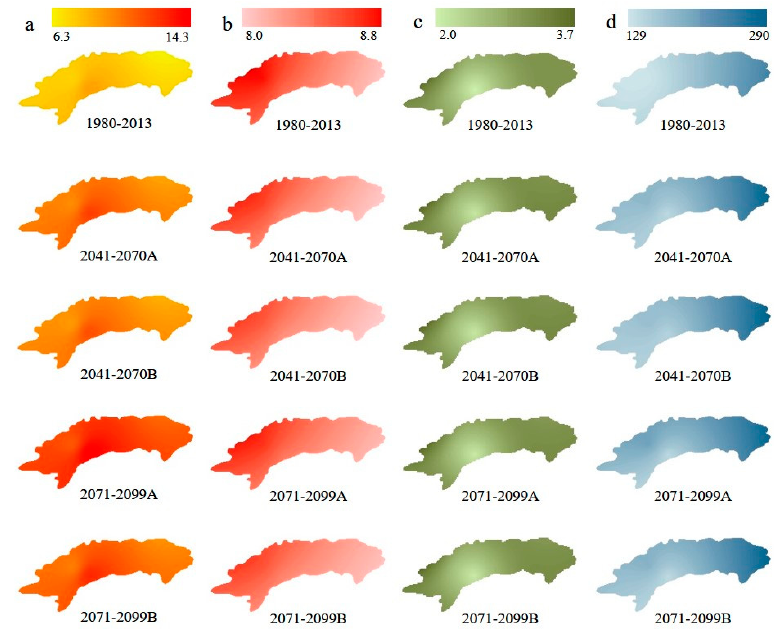
Figure 2. The spatial distribution of the parameters during different time periods. ( a ), ( b ), ( c ), and ( d ) stand for average annual temperature (°C), sunshine hours (h), wind speed (m/s), and precipitation (mm), respectively.